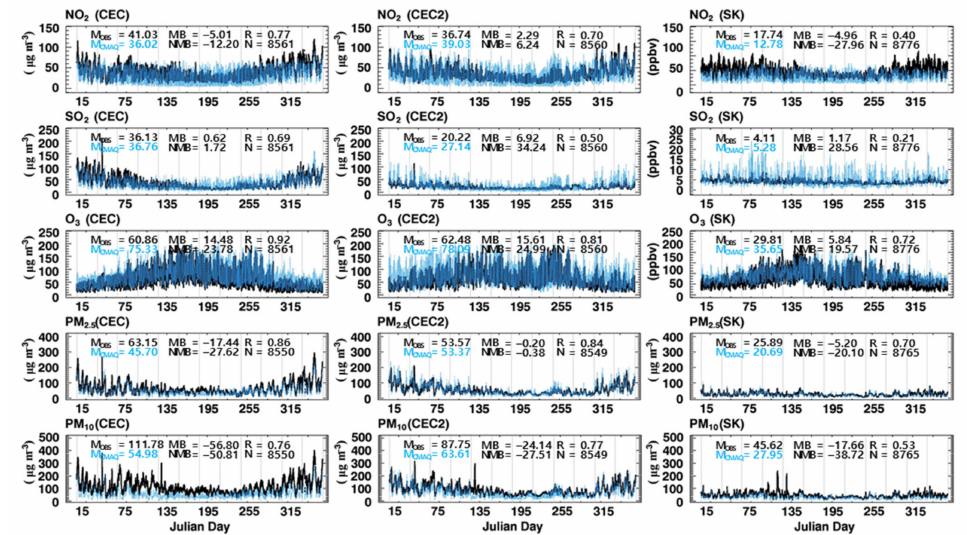
Figure 8. Time series of hourly concentrations of O 3 , PM 2.5 , and PM 10 from both observation (black lines) and simulation (blue lines) for CEC, CEC2, and SK in first, second, and third columns,